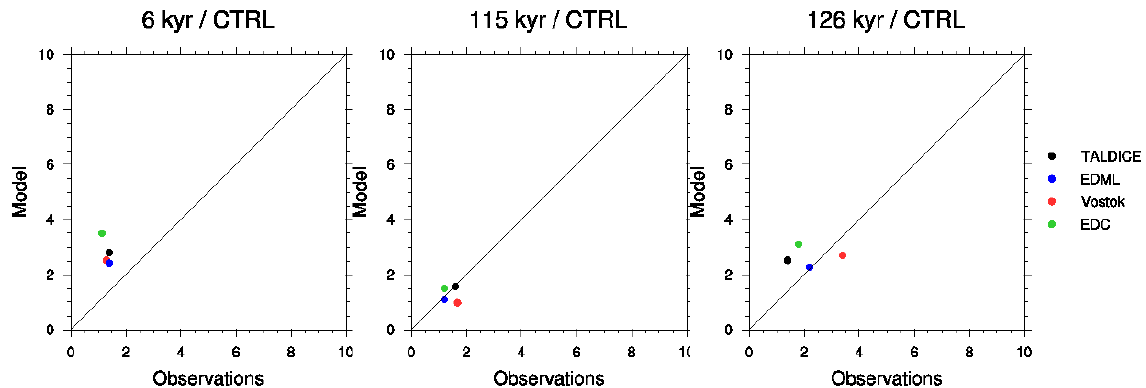
Figure 7. Dust deposition flux ratios of 6kyr (left), 115kyr (central) and 126kyr (right) to pre-industrial period from observations and model simulations. Ratios are compared for four Antarctic cites, EDC (green), Vostok (red), EDML (blue) and TALDICE (black).